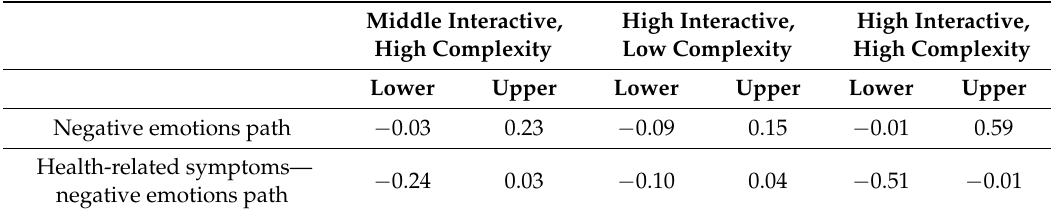
Table 3. Monte Carlo simulation for the indirect